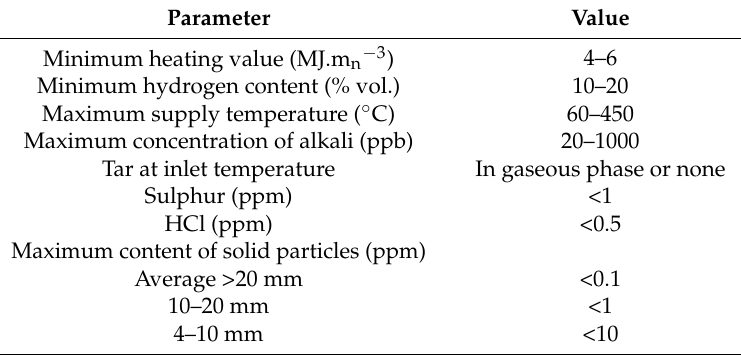
Table 1. Requirements for gas quality for gas turbines [17].